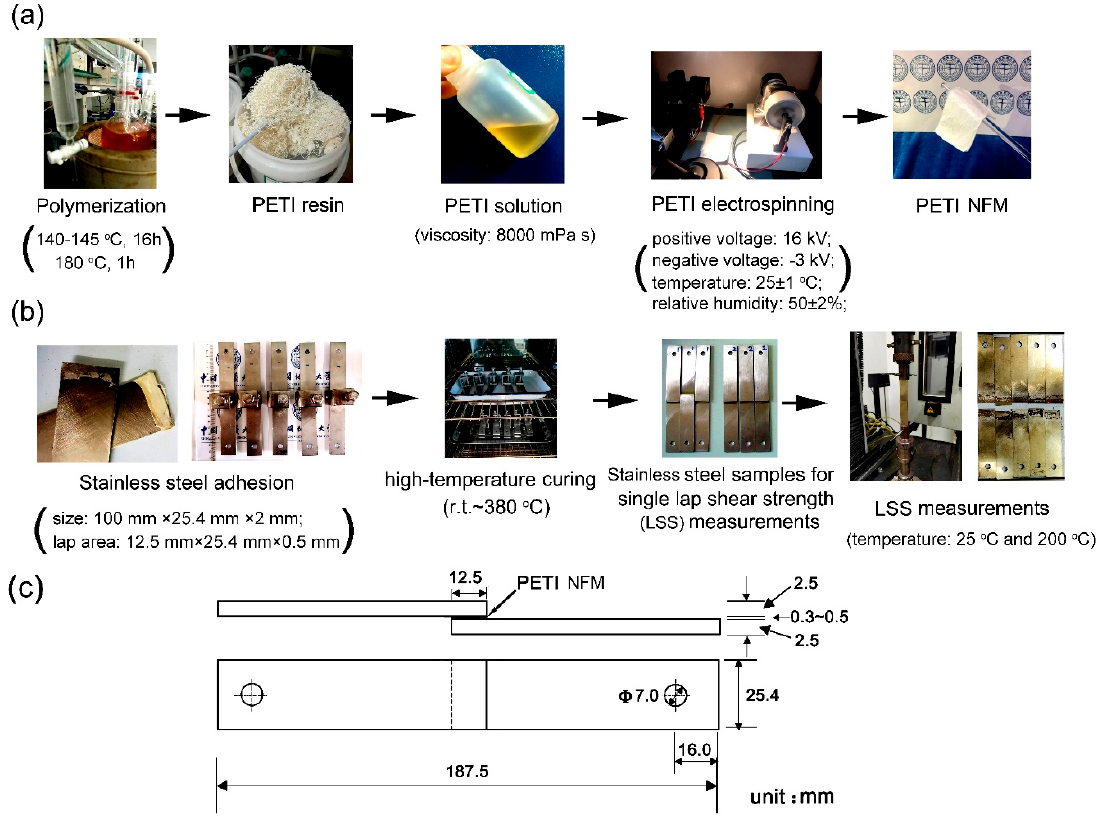
Figure 4. ( a ) Fabrication procedure of PI membranes via electrospinning; ( b ) Fabrication of stainless steel samples for lap shear strength (LSS) measurements; ( c ) Diagram for the sizes of adhesion samples.